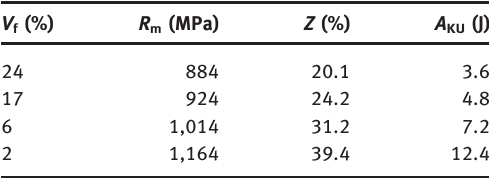
Table 2: The results of tensile and impact